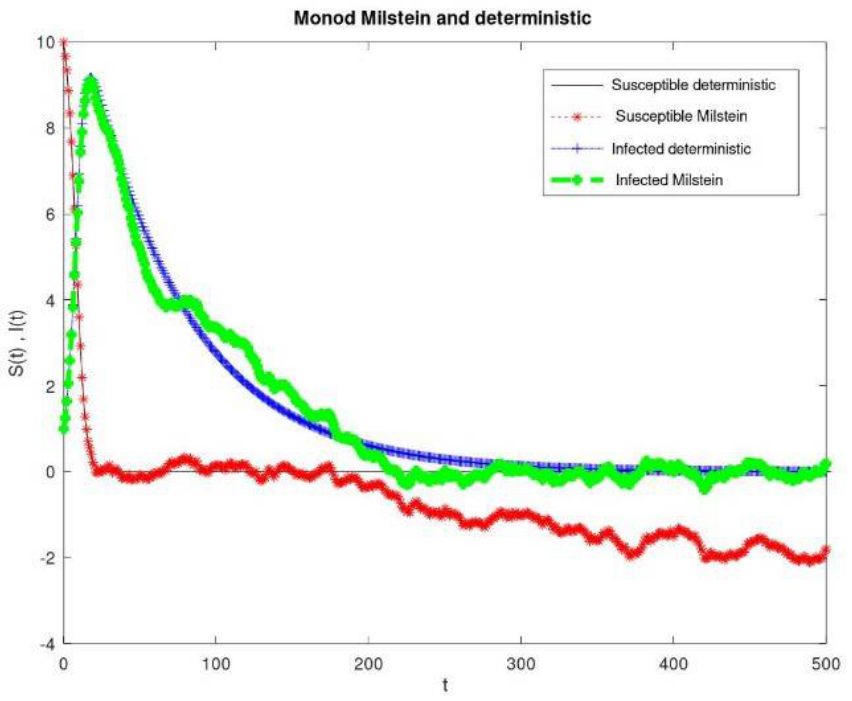
Figure 3. Plot of the dynamic behaviors of the susceptible and infected populations under the intervals (cid:101) β = 0.03 and (cid:101) γ = 0.015 .